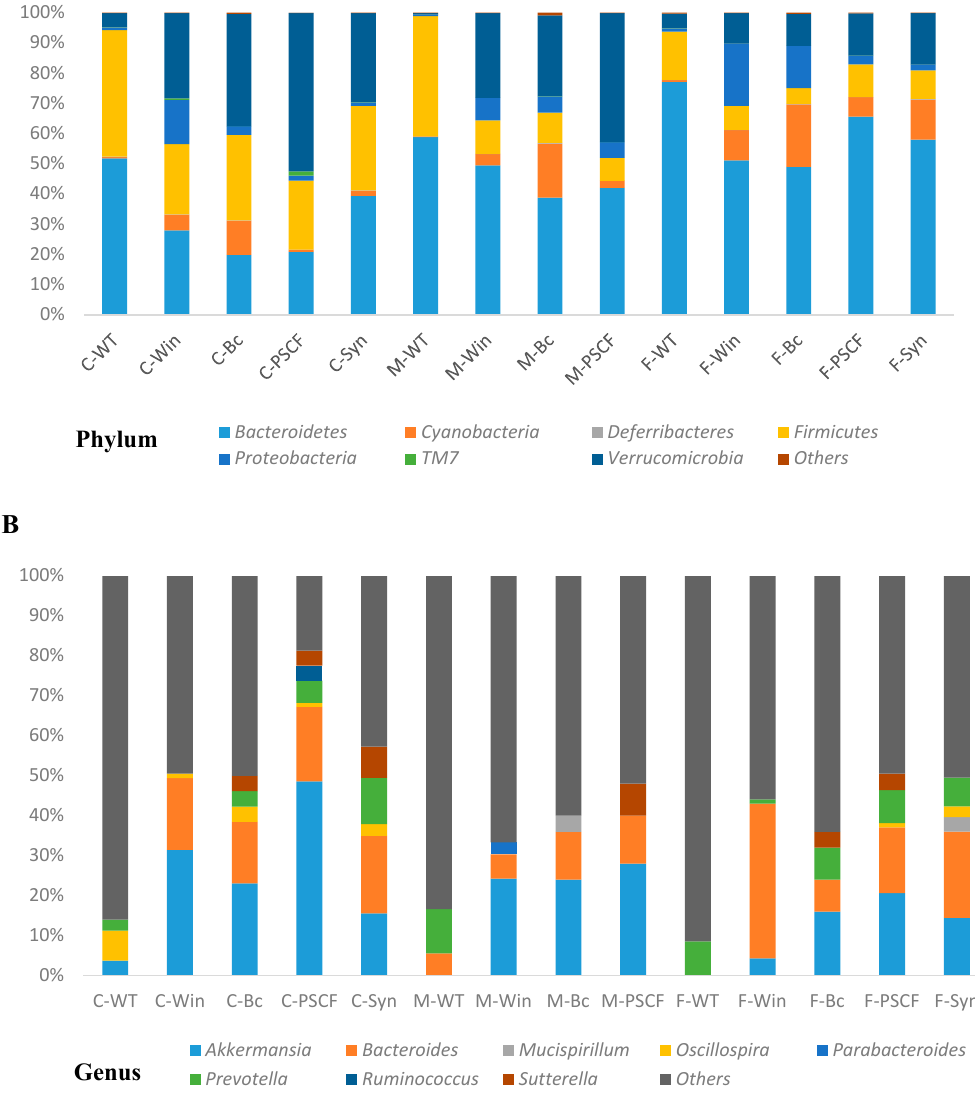
Figure 7. Relative abundances (%) of caecal (C)-, mucosal (M)- and Faecal (F)- associated microbiota at ( A ) phylum and ( B ) genus level observed in wild-type (WT), Winnie-control (Win), B. coagulans (Bc) spores, PSCF and Synbiotic (Syn) groups; ( n = 5 per group).